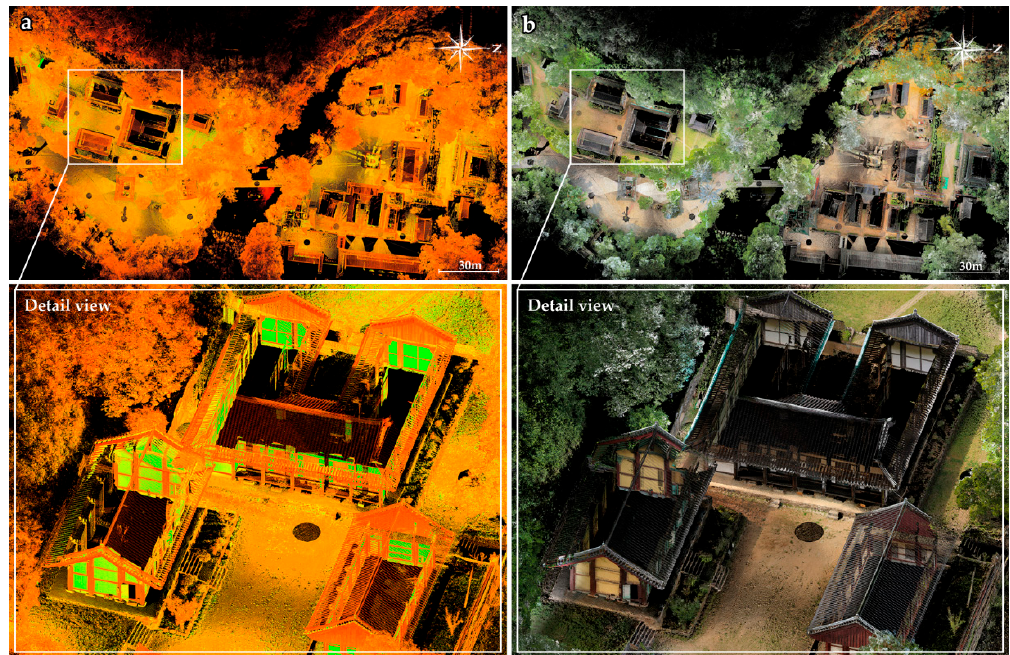
Figure 3. Orthoimage and detailed view of the Magoksa Temple created via terrestrial laser scanning: ( a ) reflectance intensity image; ( b ) RGB texture mapping image.